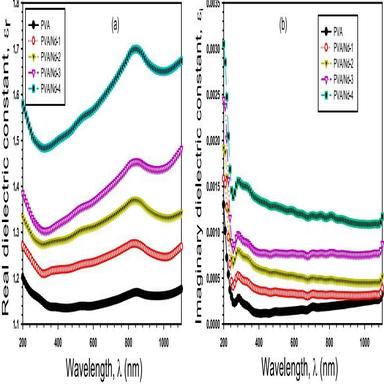
(a) Real with λ, and (b) imaginary constants with λ, for PVA and PVA/Nd2O3.